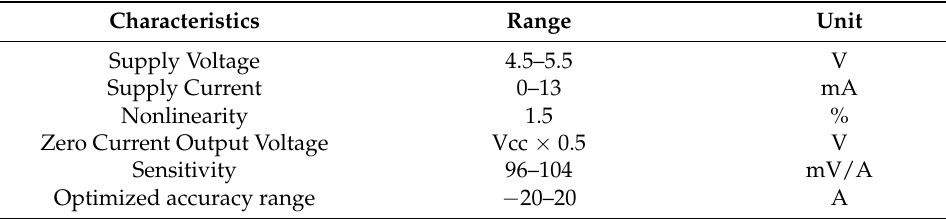
Table 2. Technical characteristics of F 034-06.